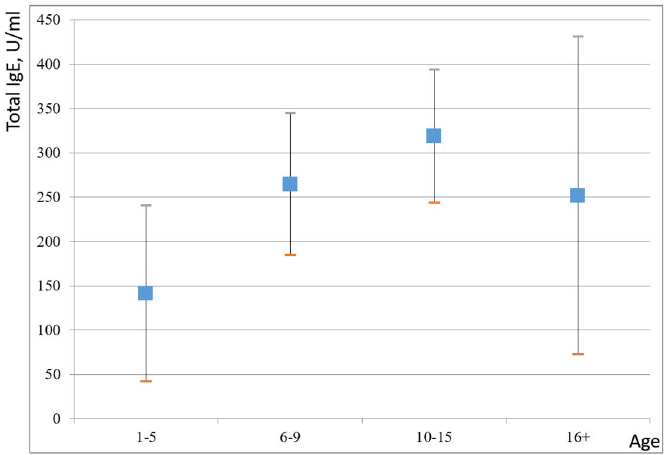
Figure 3. Serum level of total IgE.